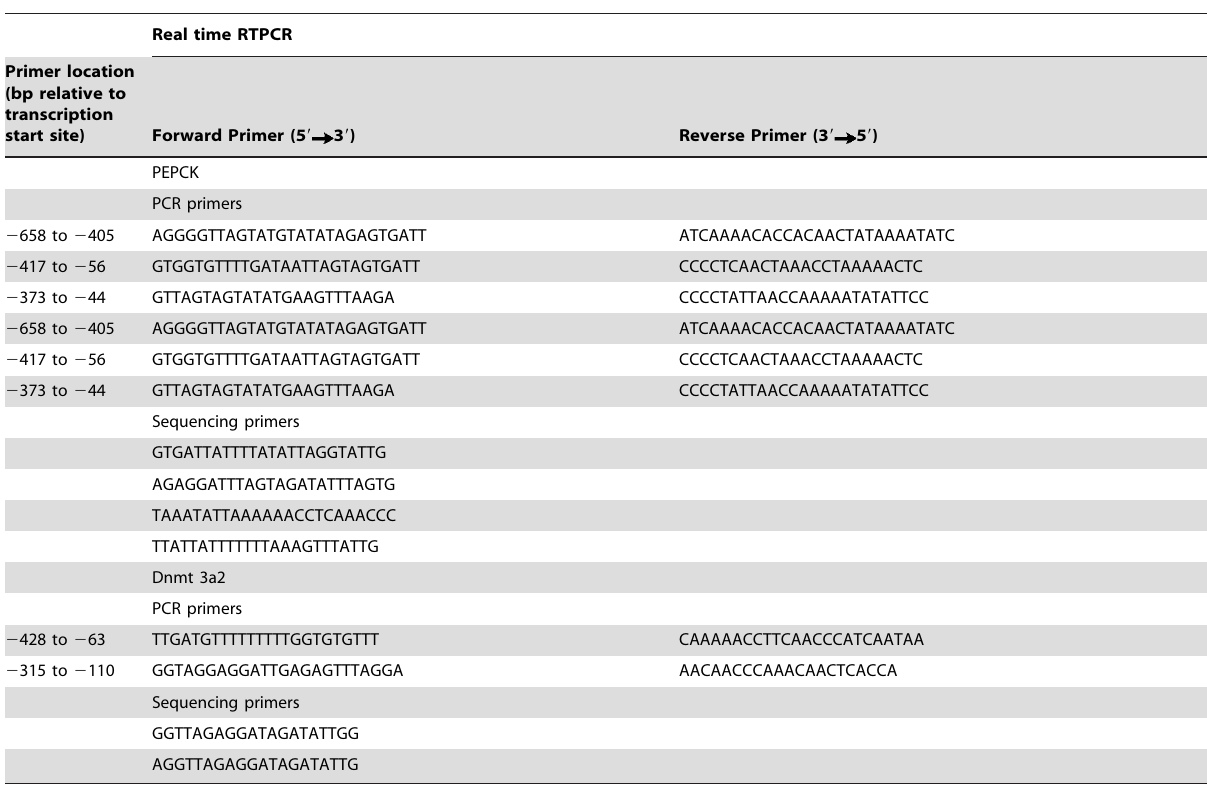
Table 3. Pyrosequencing